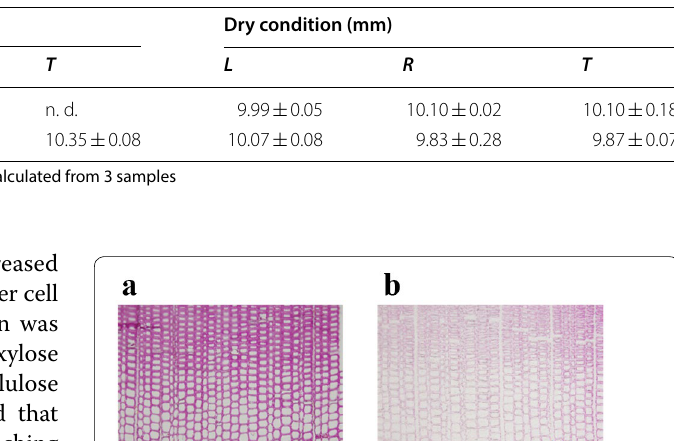
Table 3 Size durability of untreated and colorless wood